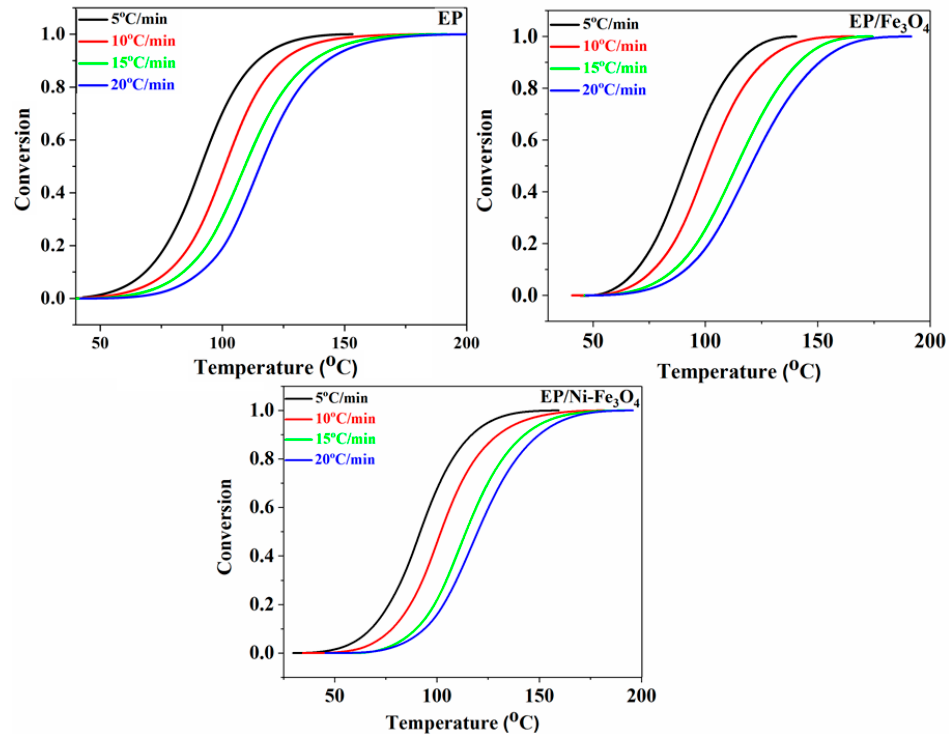
Figure 4. Profile variation of the fractional extent of cure, α versus reaction temperature for EP, EP/Fe 3 O 4 [29] and EP/Ni-Fe 3 O 4 nanocomposites at different heating rates of 5, 10, 15 and 20 °C/min.